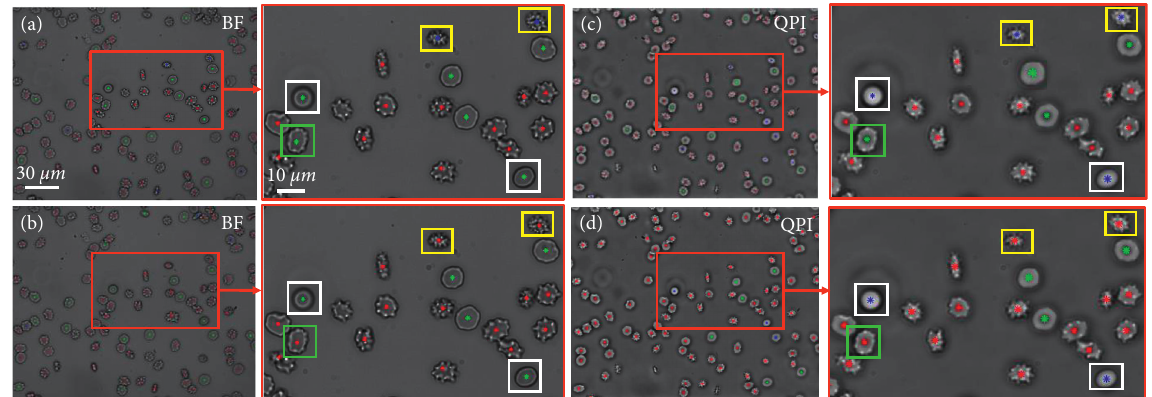
Figure 9: The influence of BC on the results of RBC classification in BF and QPI. (a) RBC classification without BC in BF. (b) RBC classification without BC in QPI. (c) RBC classification with BC in BF. (d) RBC classification with BC in QPI. Red, green, and blue dots indicate that the predicted results are echinocyte-shaped RBCs, discocyte-shaped RBCs, and spherocyte-shaped RBCs, respectively.